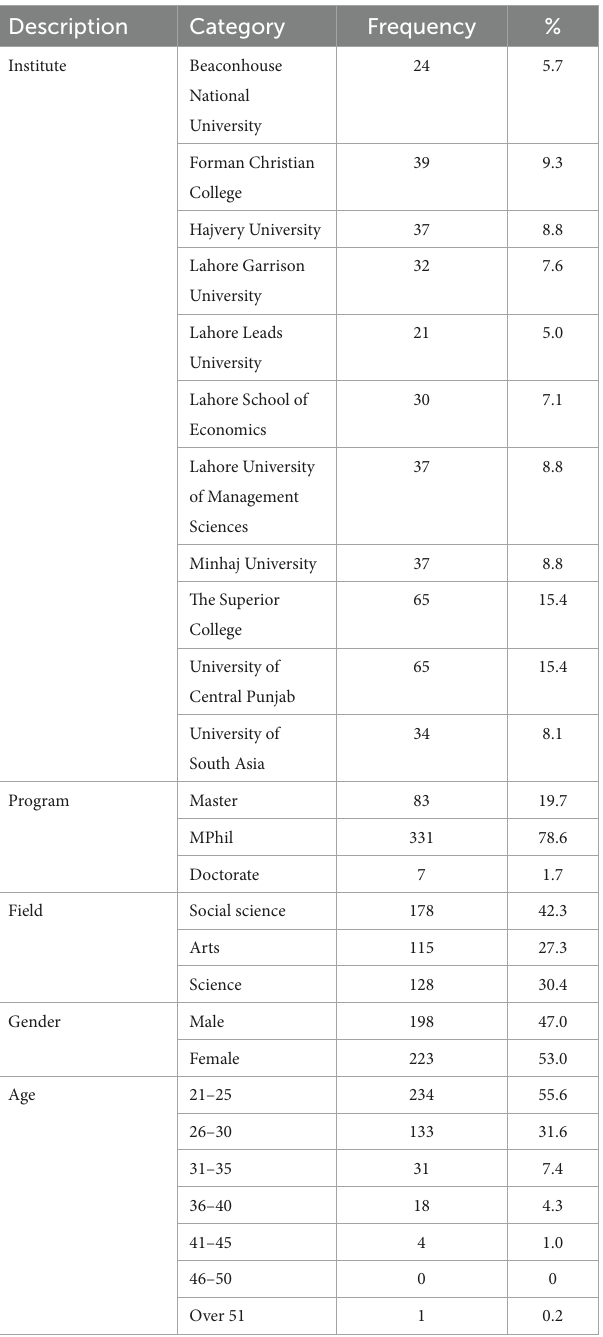
TABLE 1 Demographic information of the